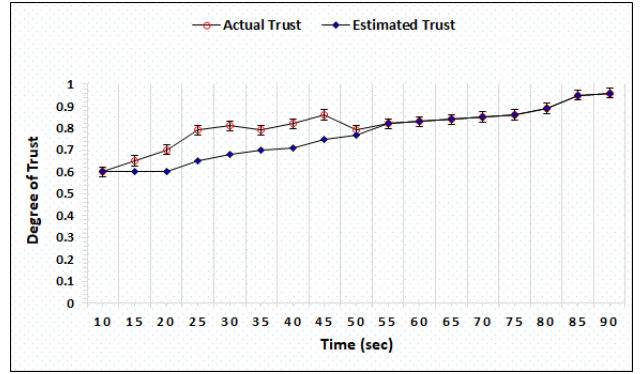
Figure 8. Trust degree of honest base